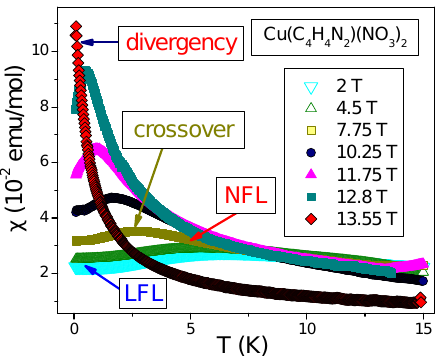
Figure 9. Temperature dependence of χ ( T ) for CuPzN. The experimental data are from [25]. The magnetic fields are shown in the legend. The three regions LFL, NFL and crossover are shown. The divergent behavior of χ ( T ) at B = B s is indicated by the black